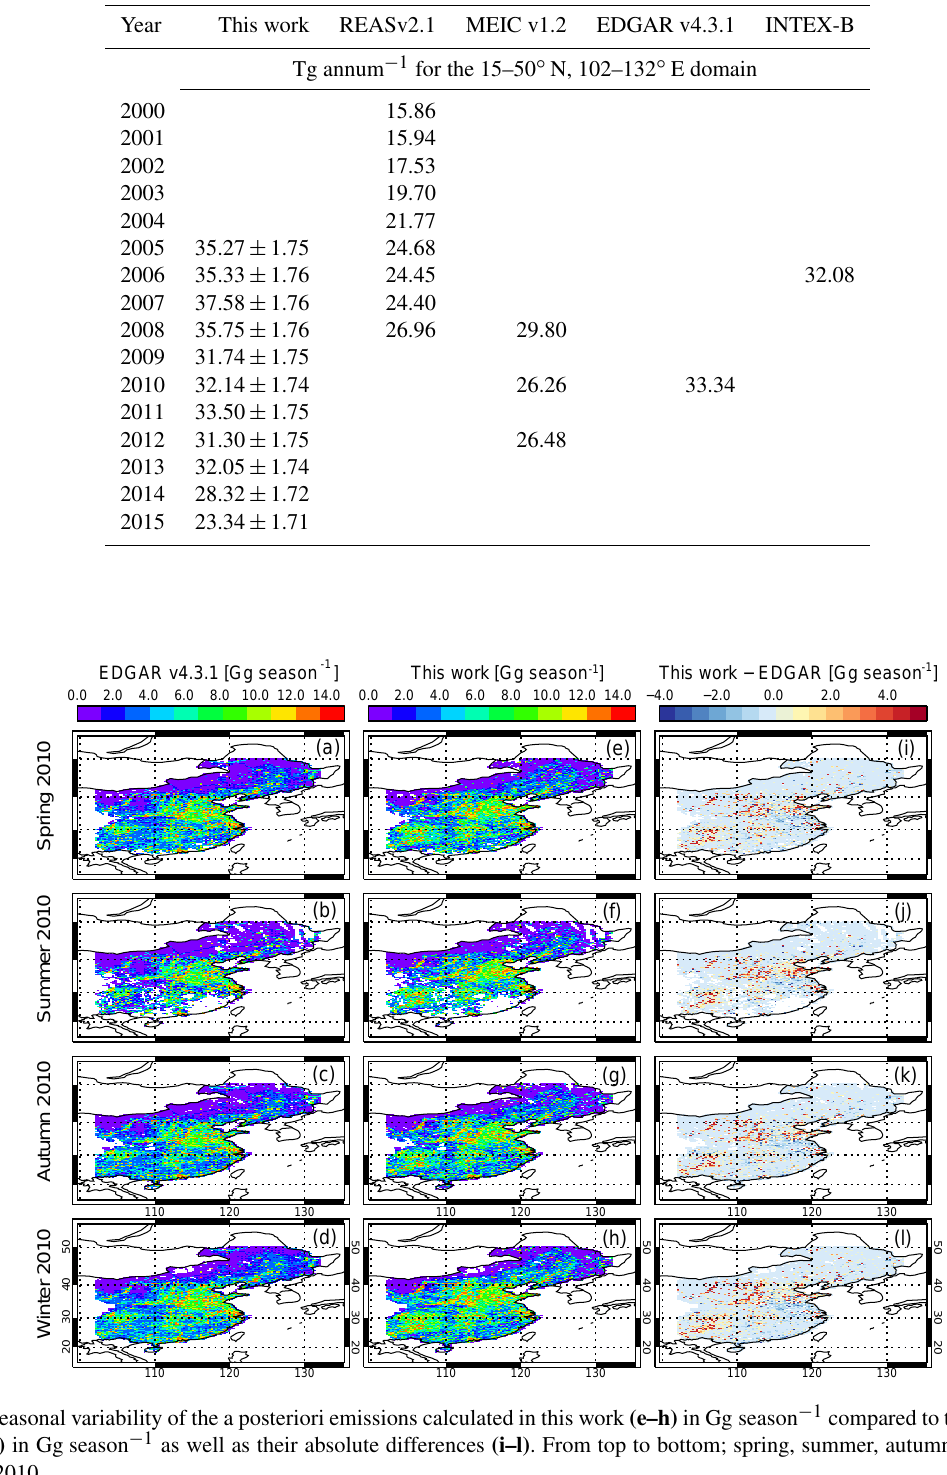
Table 3. Annual SO 2 emissions over the domain 15–50 ◦ N, 102–132 ◦ E in teragrams per year. First column, the year; second column, this work; third column, the REASv2.1; fourth column, EDGAR v4.3.1; and fifth column, the INTEX-B database.